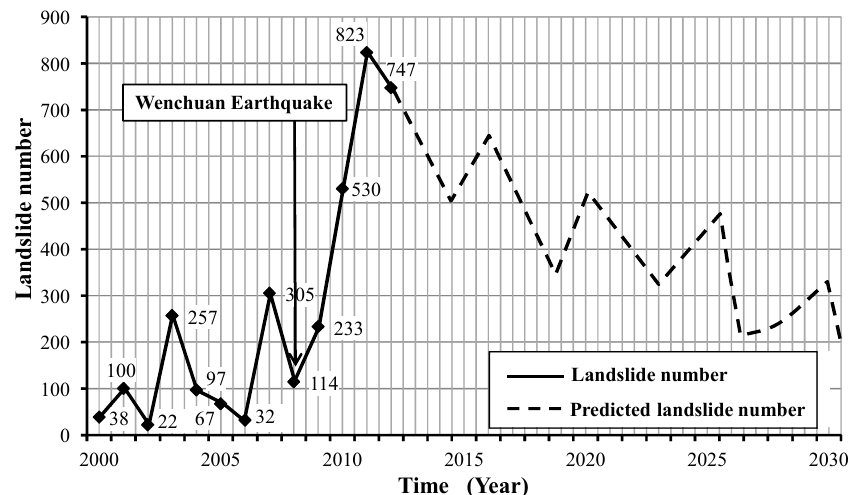
Figure 9. Incidence of catastrophic landslides induced by rainfall in the Wenchuan Earthquake area since 2000. Only landslides that caused losses to life and property are considered. The solid line is based on the actual records and the dashed line is a prediction [25].